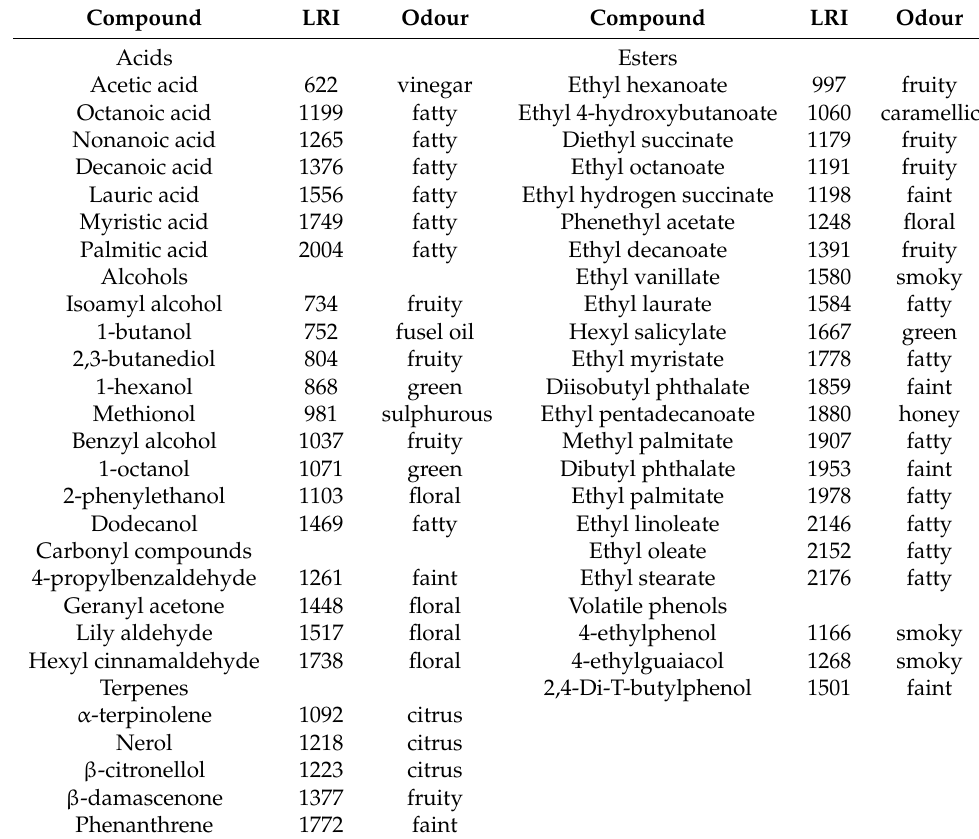
Table 3. Linear retention indices (LRI) and odour description of volatile compounds identified in Cabernet Sauvignon wine variety and retentates obtained by reverse osmosis and nanofiltration at 2.5, 3.5, 4.5 and 5.5 MPa with and without